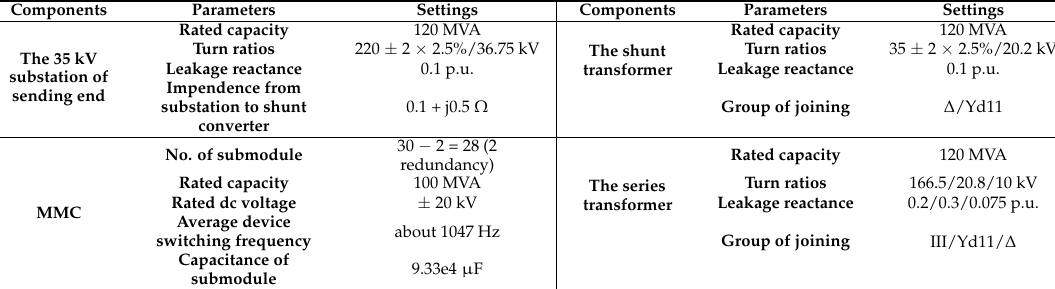
Table 4. The primary parameters of MMC-based UPFC set in simulation.